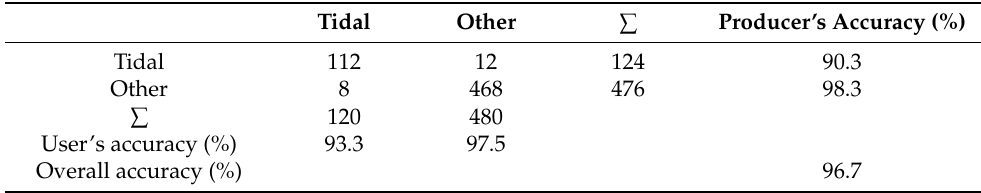
Table 5. RF-W method confusion matrix.